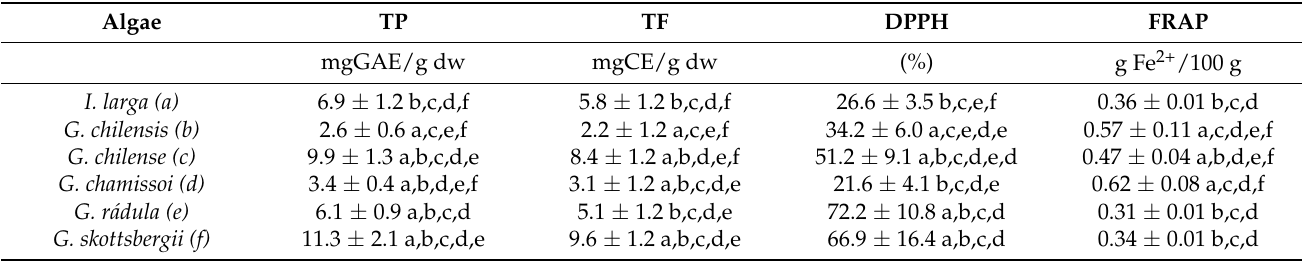
Table 2. Total polyphenols (TP), Total flavonoids (TF) contents and antiradical capacity (IC50) of algae extracts. Values correspond to the mean of three independent analyses ± standard deviation. Algae TP TF DPPH FRAP mgGAE/g dw mgCE/g dw